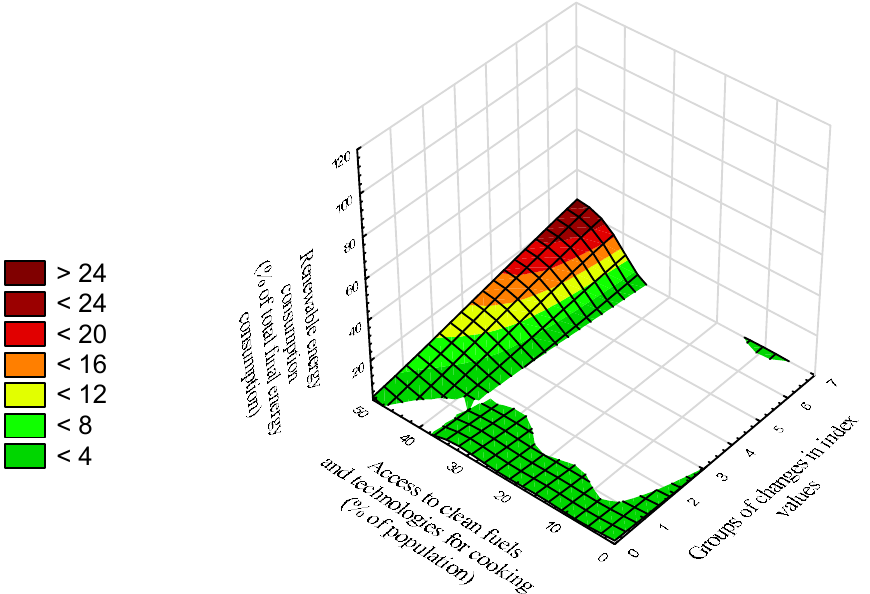
Figure 7. Distribution of the values of indicators for access to clean fuels and technologies for cooking (% of population) and renewable energy consumption (% of total final energy consumption) in relation to the classification according to changes in the values of all indicators from 2000 to 2019. Source: own study.